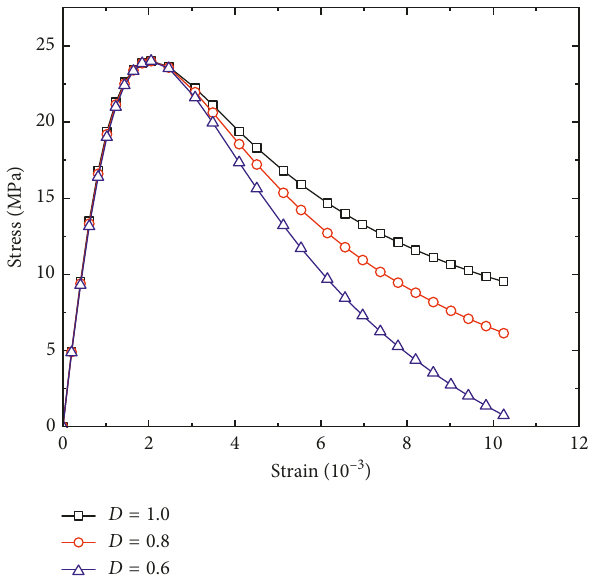
Figure 1: The compressive model of